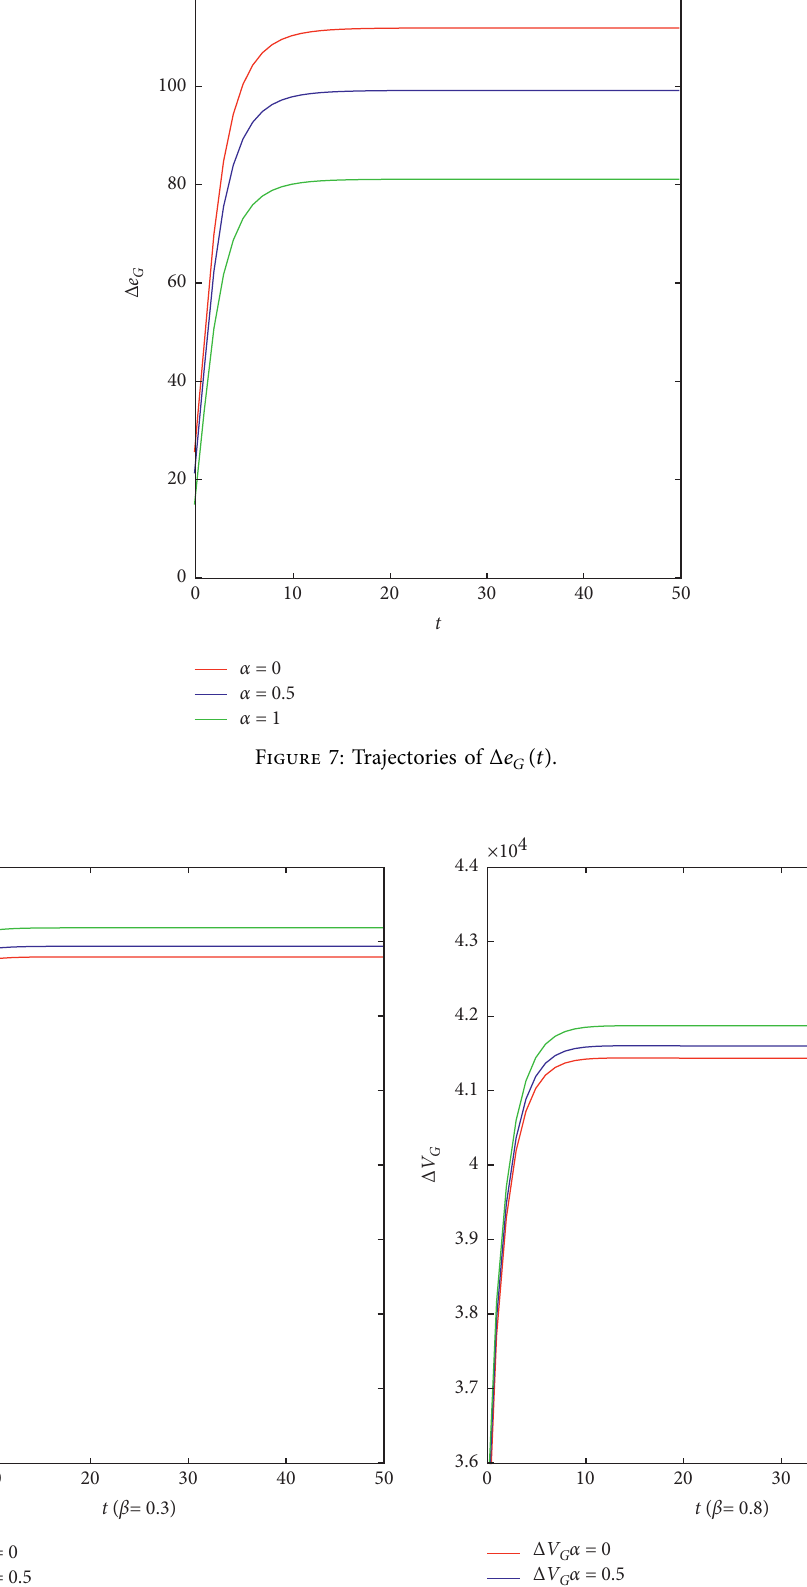
( t ) ( β � 0 . 3). (b) Trajectories of Δ V G